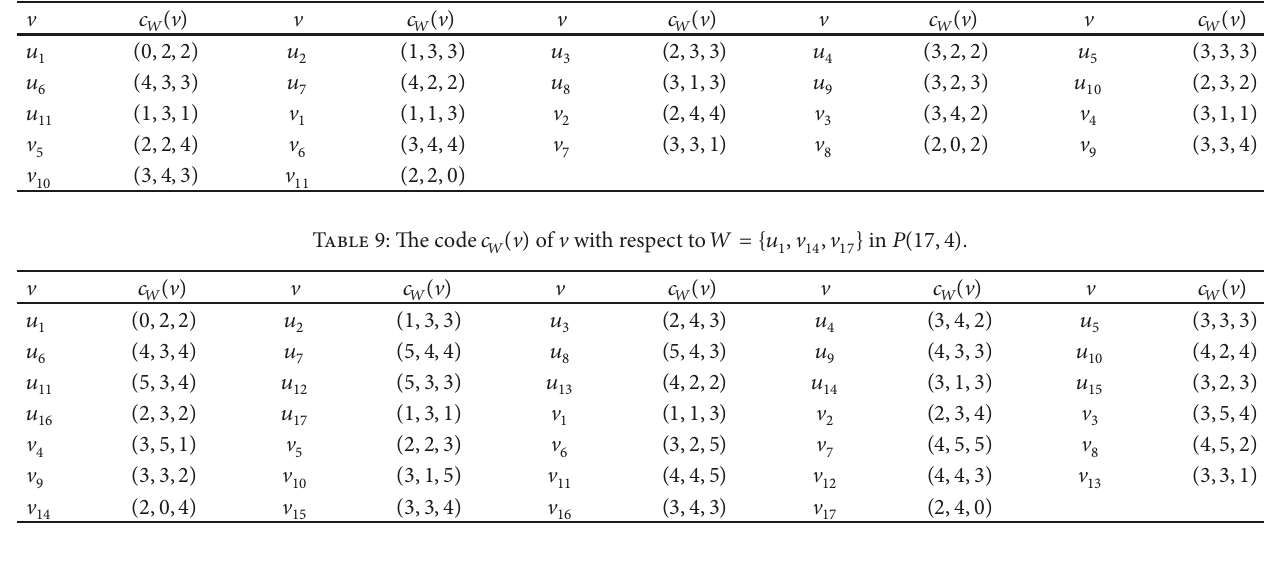
Table 8: The code 𝑐 𝑊 ( V ) of V with respect to 𝑊 = {𝑢 1 , V 8 , V 11 } in 𝑃(11,4) .